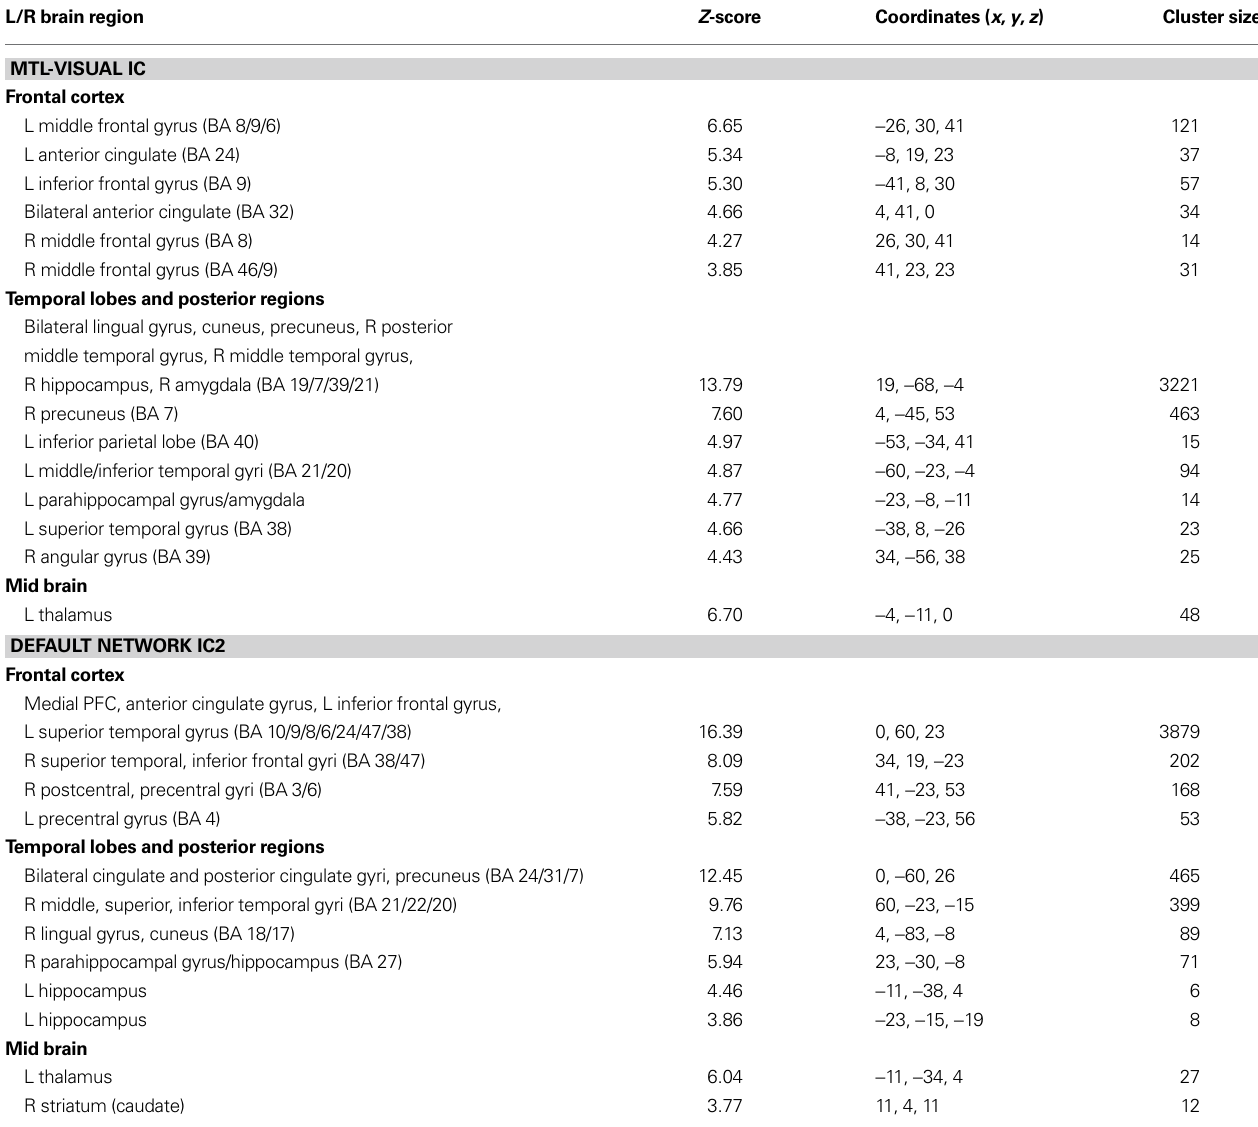
Table 2 | Independent components analysis (ICA) results during free viewing that positively correlated with behavioral ratings of emotional intensity. L/R brain region Z -score Coordinates ( x , y , z )